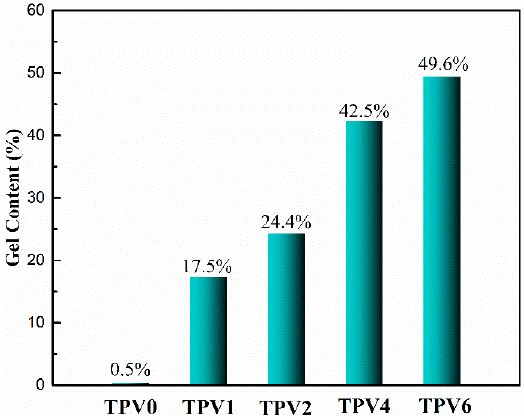
Figure 2. Gel content of TPVs with di ff erent PF incorporation.